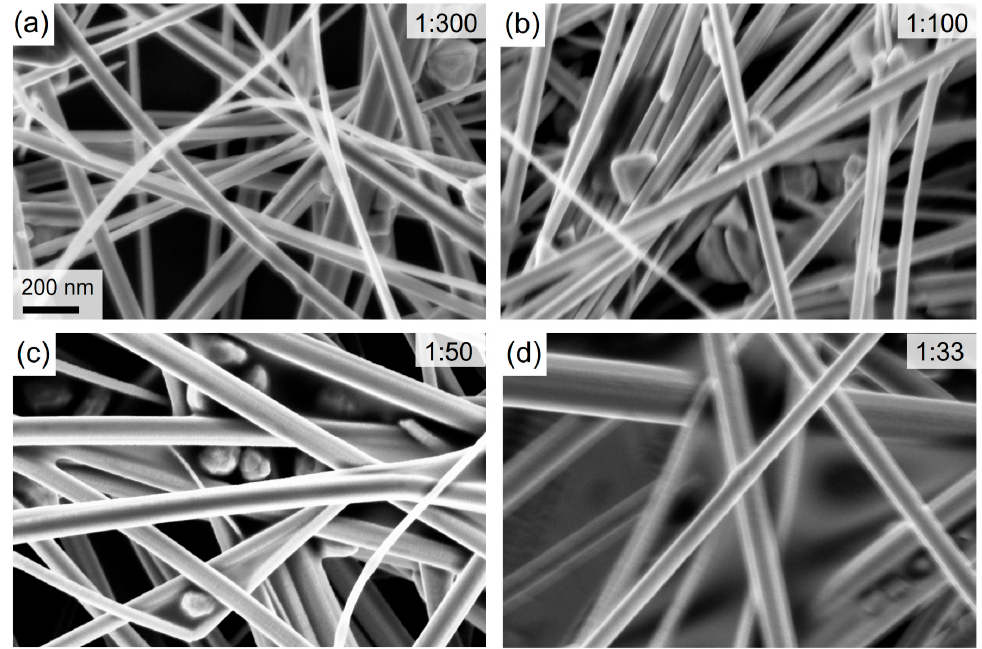
Figure A1. High-resolution FESEM-images of CuNWs for the precursor-to-solvent series with different mass ratios (precursor:solvent) of ( a ) 1:300, ( b ) 1:100, ( c ) 1:50 and ( d ) 1:33. The scale bar in ( a ) applies to all images.